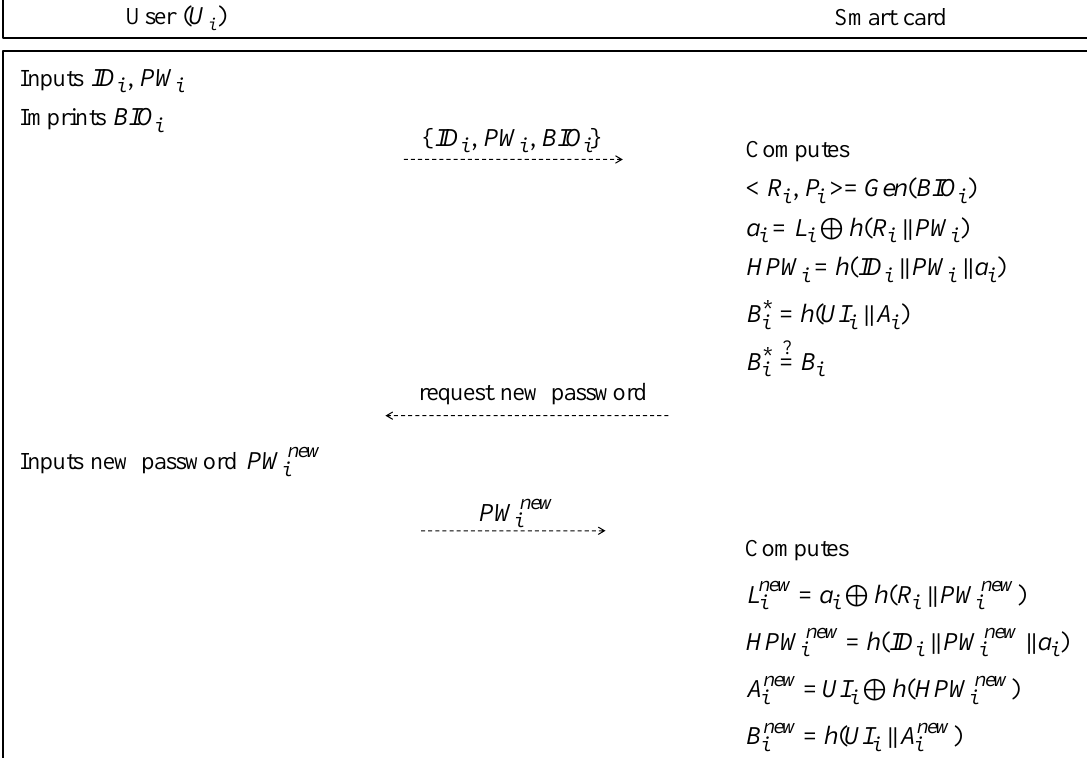
Figure 7. Password change phase of our proposed